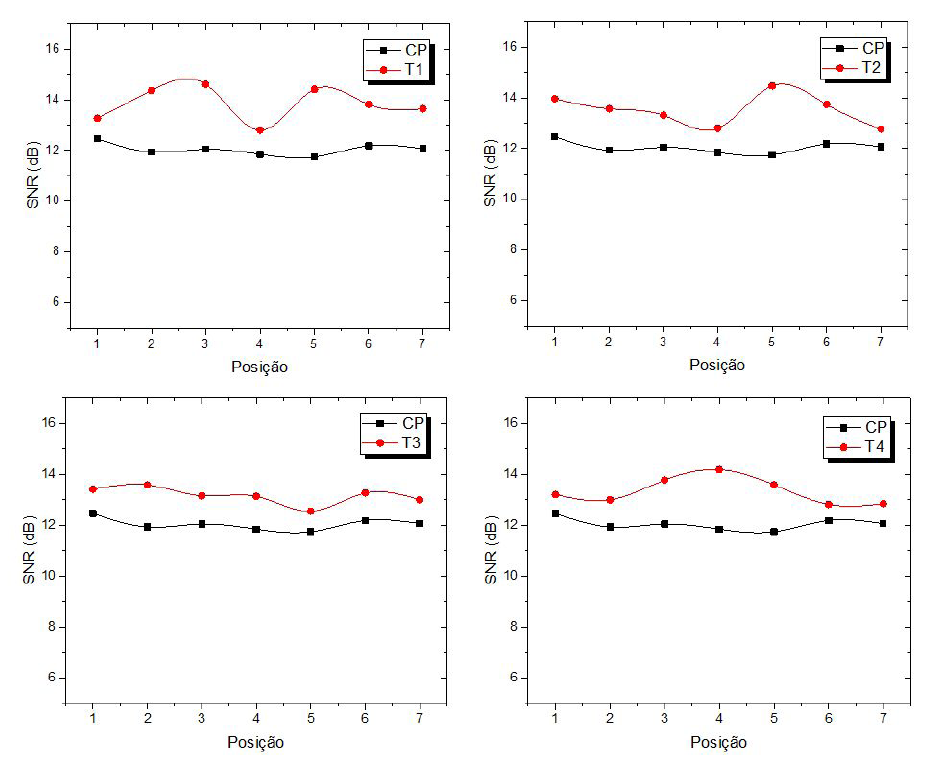
Figure 11. Results of the SNR for samples with